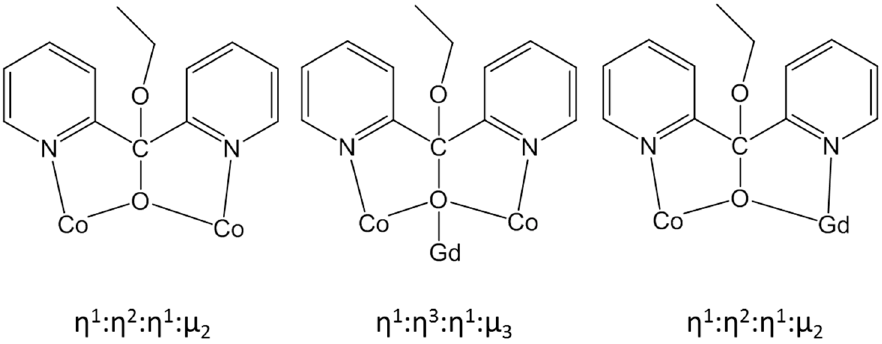
Scheme 2. A schematic representation of the coordination modes of (py) 2 C(OEt)(O) − in 1